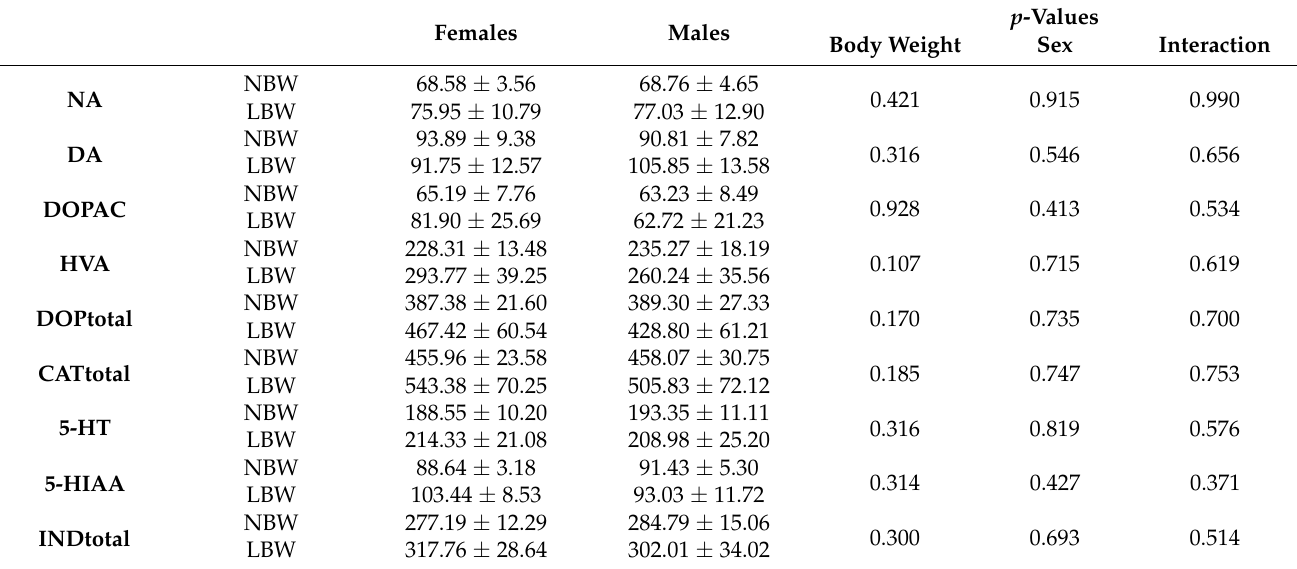
Table 3. Concentration of neurotransmitters and their metabolites in the hippocampus of 100-day-old fetuses as a function of body weight and